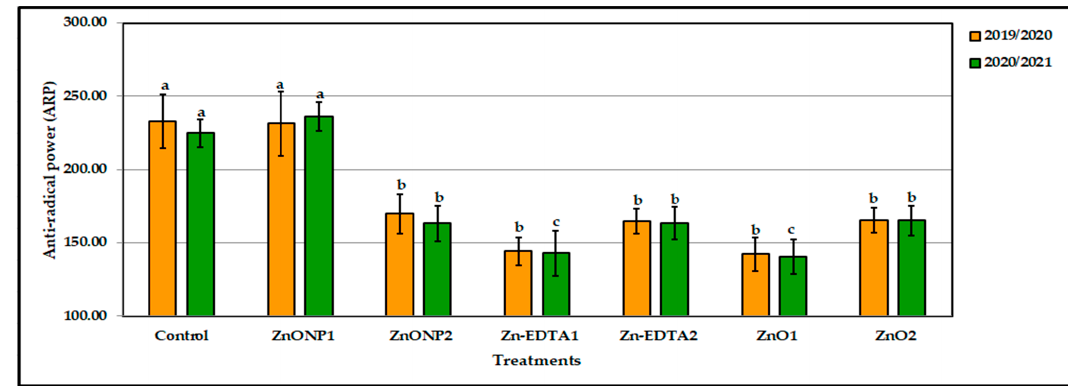
Figure 2. Influence of exogenous foliar application with some different zinc forms on anti-radical power (ARP) of root carrot grown under zinc-deficit stress in 2019/2020 and 2020/2021 growth seasons. Bars with a different letter indicate significant difference between treatments at p ≤ 0.05.